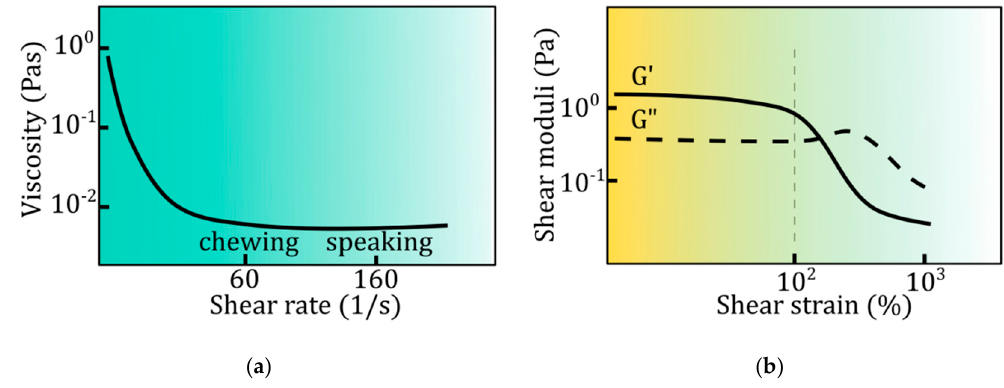
Figure 3. Rheological properties of human saliva: ( a ) viscosity in shear rate function, ( b ) shear moduli (G’ is an elastic/storage modulus, G” is viscous/loss modulus) in shear strain function.